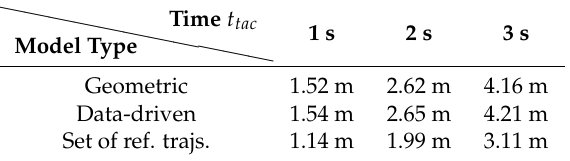
Table 2. Mean error (smaller is better) in state prediction in tactical